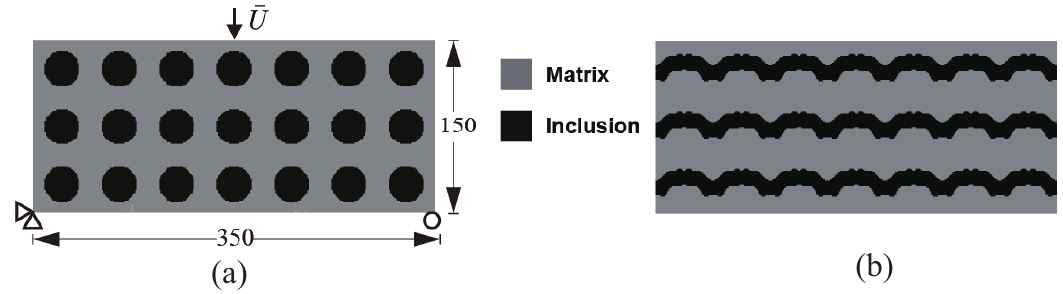
Figure 3. Periodic composite without initial crack subjected to three-point bending: ( a ) boundary conditions and geometry of the initial design; ( b ) final